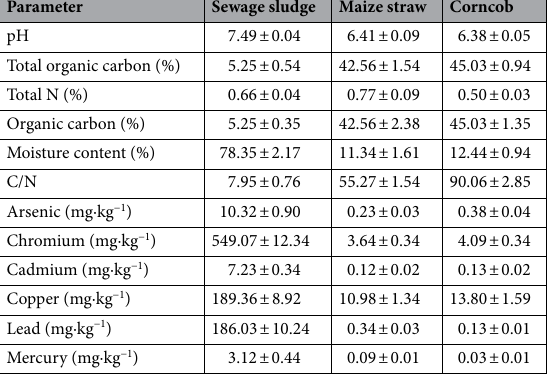
Table 2. Physicochemical properties of common composting materials (n = 3).